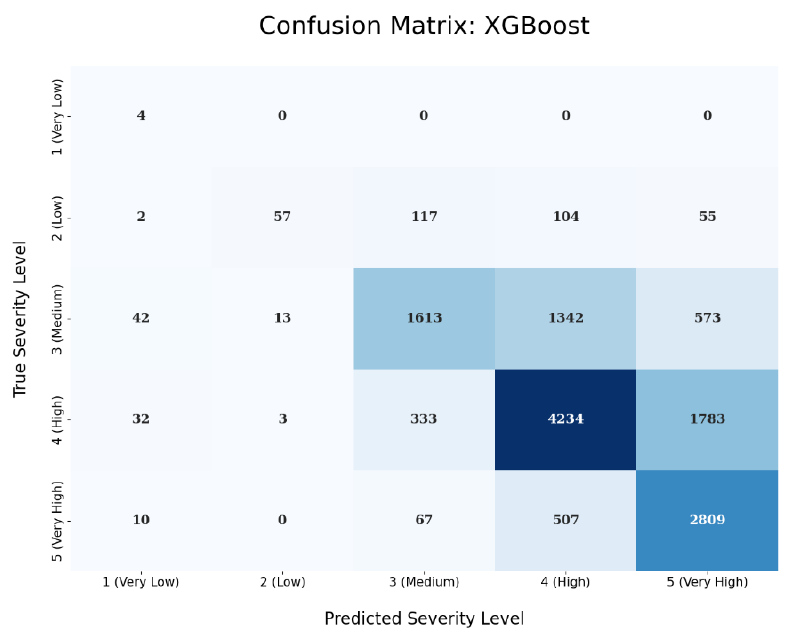
Figure 9. Confusion Matrix for